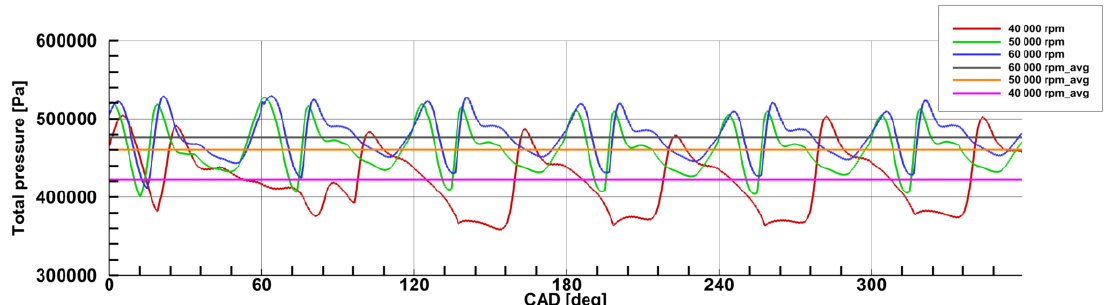
Figure 12. The inter Section of pressure plots monitored at the Section 1-1 for three different turbine speeds during the 3rd revolution of the crankshaft.